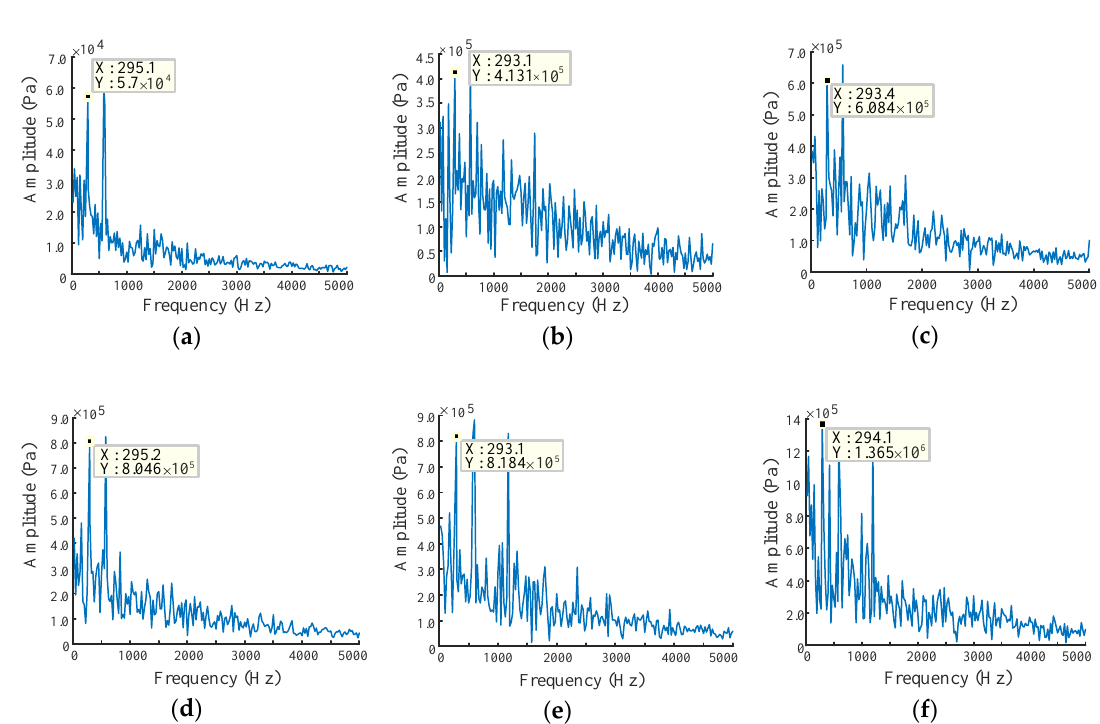
Figure 13. Fast Fourier transform (FFT) of pressure signal under di ff erent radial wear gaps: ( a ) wear gap is 20 µ m; ( b ) wear gap is 40 µ m; ( c ) wear gap is 60 µ m; ( d ) wear gap is 80 µ m; ( e ) wear gap is 100 µ m; ( f ) wear gap is 120 µ m.